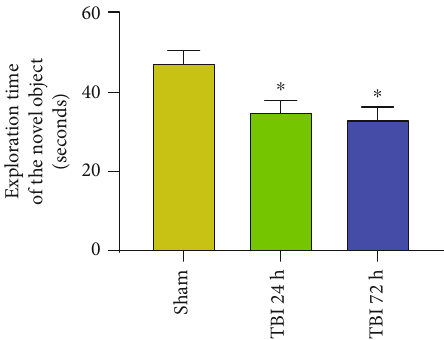
Figure 8: NOR test was conducted to assess memory function in TBI mice. The mouse was exposed to two similar objects (A, A) to familiarize in an open fi eld arena box apparatus for 5min a day before TBI procedures ( n = 6 mice/group). The time spent near the objects was recorded. Then, the mouse was exposed to one familiar object (A) and a novel object (B) for 5min, and the time spent at each object was recorded after 24h and 72h of TBI procedure. Results show that sham control mice show increased time spent at the novel object than at the familiar object ( ∗ p < 0 : 05 ). However, TBI mice show poor performance as they did not recognize the familiar object, and the time spent at the familiar object and novel object did not show any signi fi cant